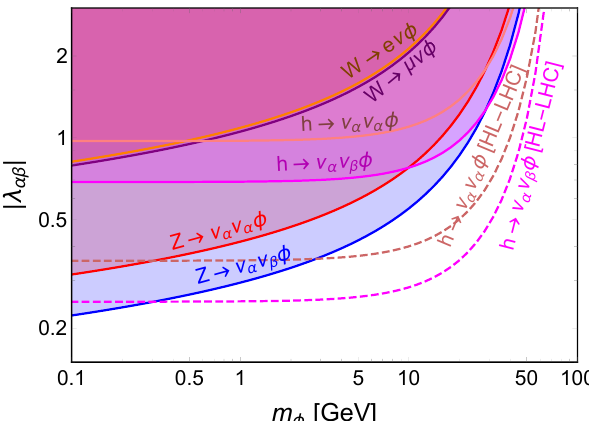
Figure 4 . Limits on j (cid:21) (cid:11)(cid:12) j (with (cid:11); (cid:12) = e; (cid:22) ) from invisible Z decay Z ! (cid:23) (cid:11) (cid:23) (cid:11) (cid:30) (red), (cid:23) (cid:11) (cid:23) (cid:12) (cid:30) with (cid:11) 6 = (cid:12) (blue), the decay W ! e(cid:23)(cid:30) (orange), (cid:22)(cid:23)(cid:30) (purple) and invisible decay of the SM Higgs h ! (cid:23) (cid:11) (cid:23) (cid:11) (cid:30) (pink), (cid:23) (cid:11) (cid:23) (cid:12) (cid:30) with (cid:11) 6 = (cid:12) (magenta). The data can be found in table 1, and all the shaded regions are excluded. The dashed pink and magenta lines denote the limits from the prospects of invisible decay of the SM Higgs at the